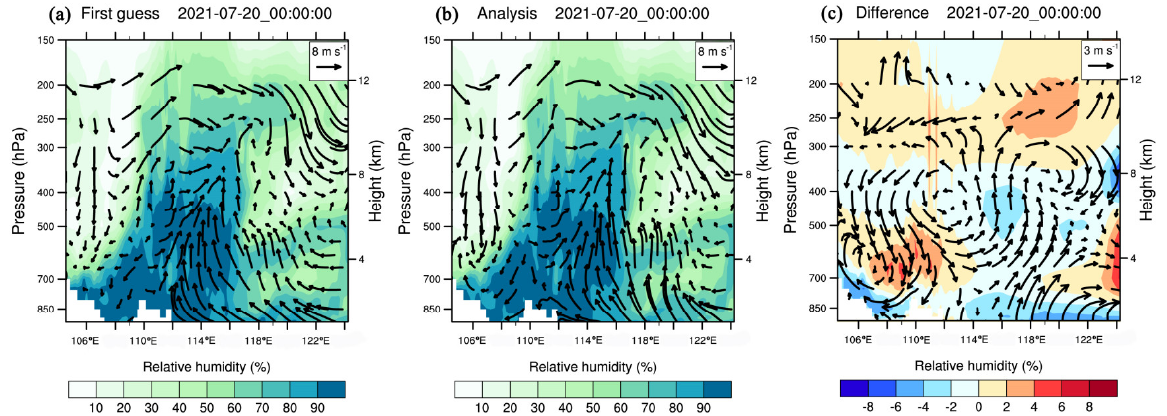
Figure 13. Cross sections of wind field and relative humidity along 34.72°N for ( a ) the first guess, ( b ) the analysis and ( c ) their difference in the amv_qi80 experiment at 00 UTC 20 July 2021.